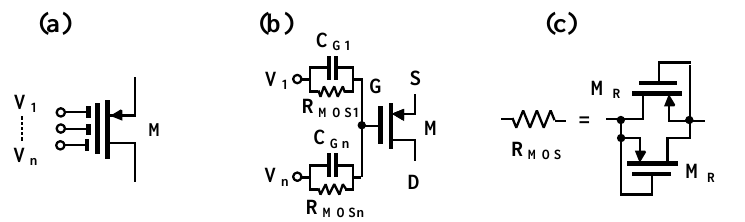
Figure 3. MI-MOST: ( a ) symbol; ( b ) realization; ( c ) realization of the large resistance value.